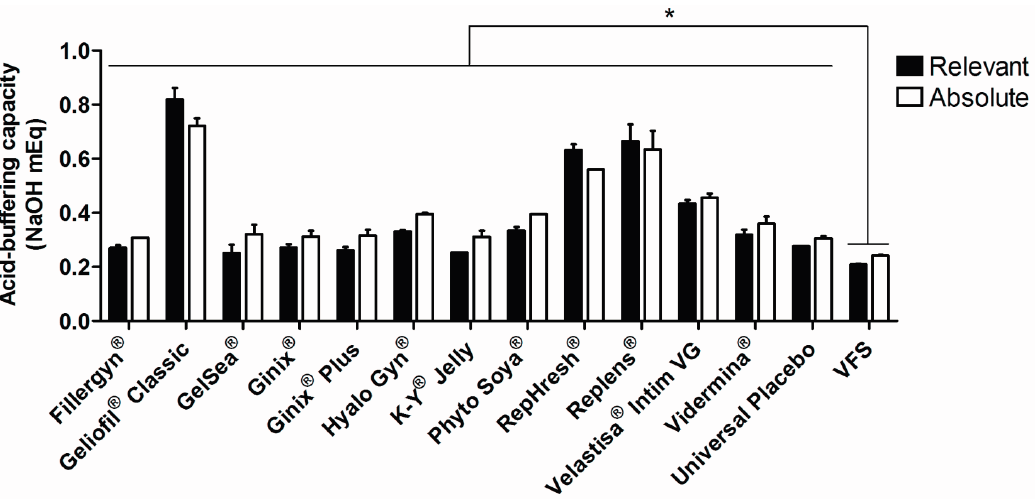
Figure 2. Relevant and absolute buffering capacity of tested products in vaginal fluid simulant (VFS). Individual columns and vertical bars represent mean and SD values, respectively ( n = 2–3). ( * ) Denotes a significant difference ( p ˂ 0.05) when comparing to values of relevant or absolute buffering capacity for plain